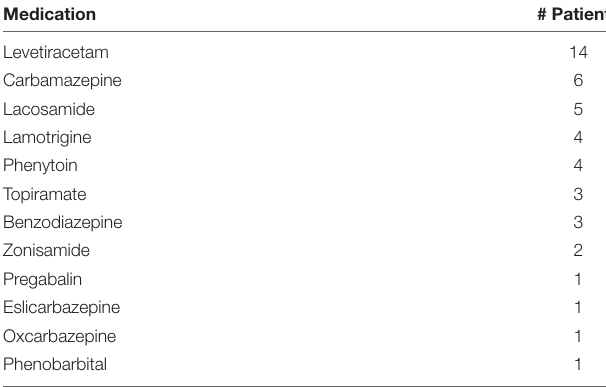
TABLE 1 | Antiseizure medications